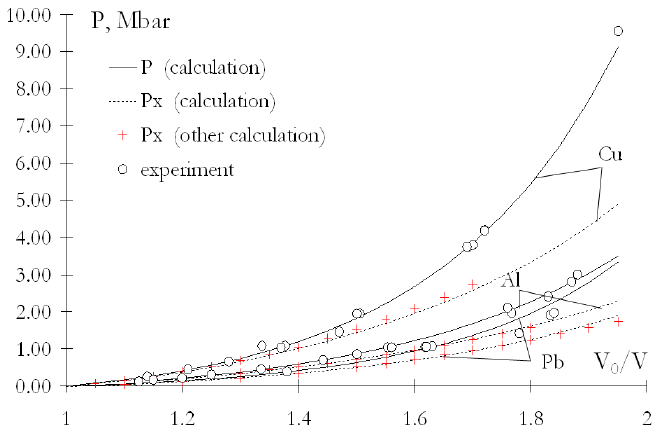
Figure 2: Adiabat solid. Experiments